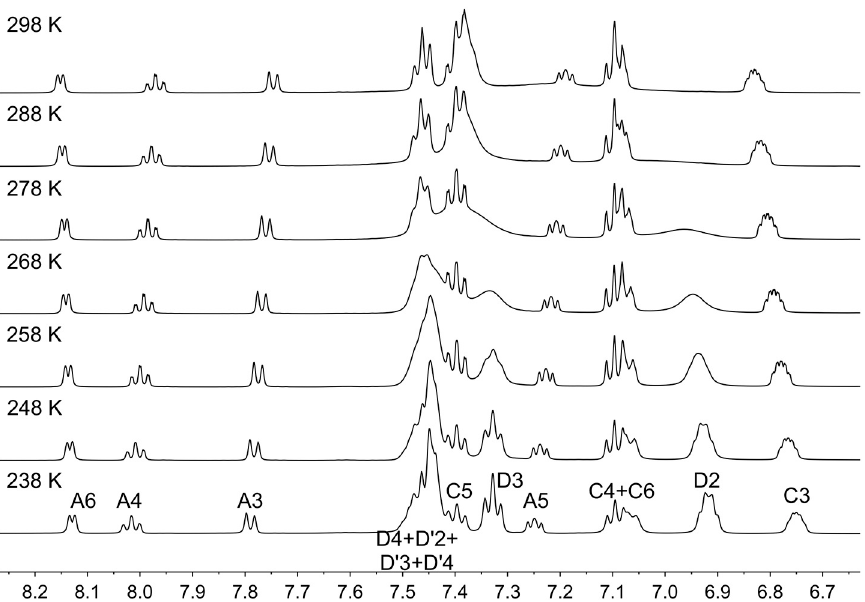
Figure 4. Aromatic region in the variable temperature 1 H NMR spectra of [Cu(POP)( i PrSPy)][PF 6 ] (500 MHz, acetone- d 6 ).